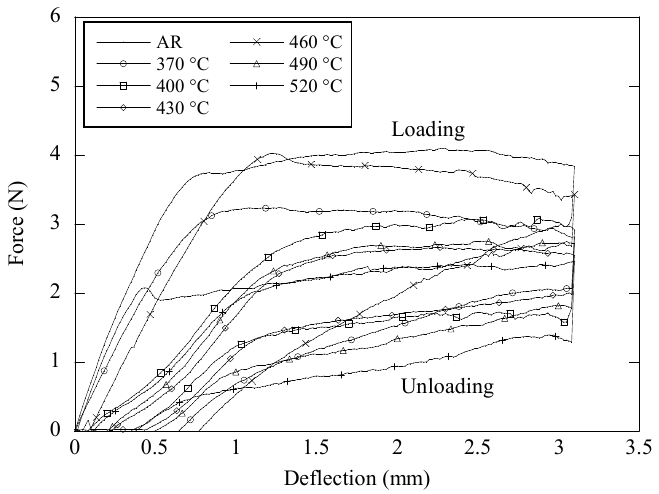
Figure 2. Force–deflection curves of aged NiTi archwires obtained from the three-point bending test.